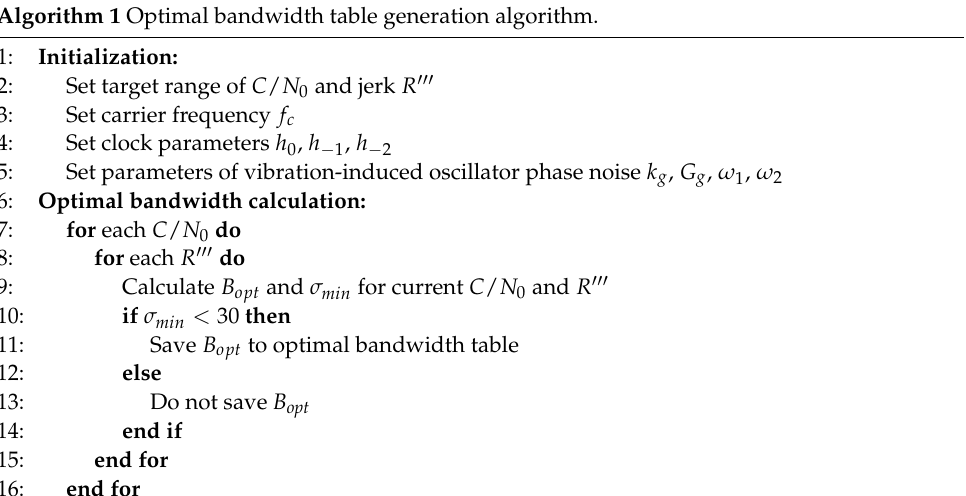
Algorithm 1 Optimal bandwidth table generation algorithm.